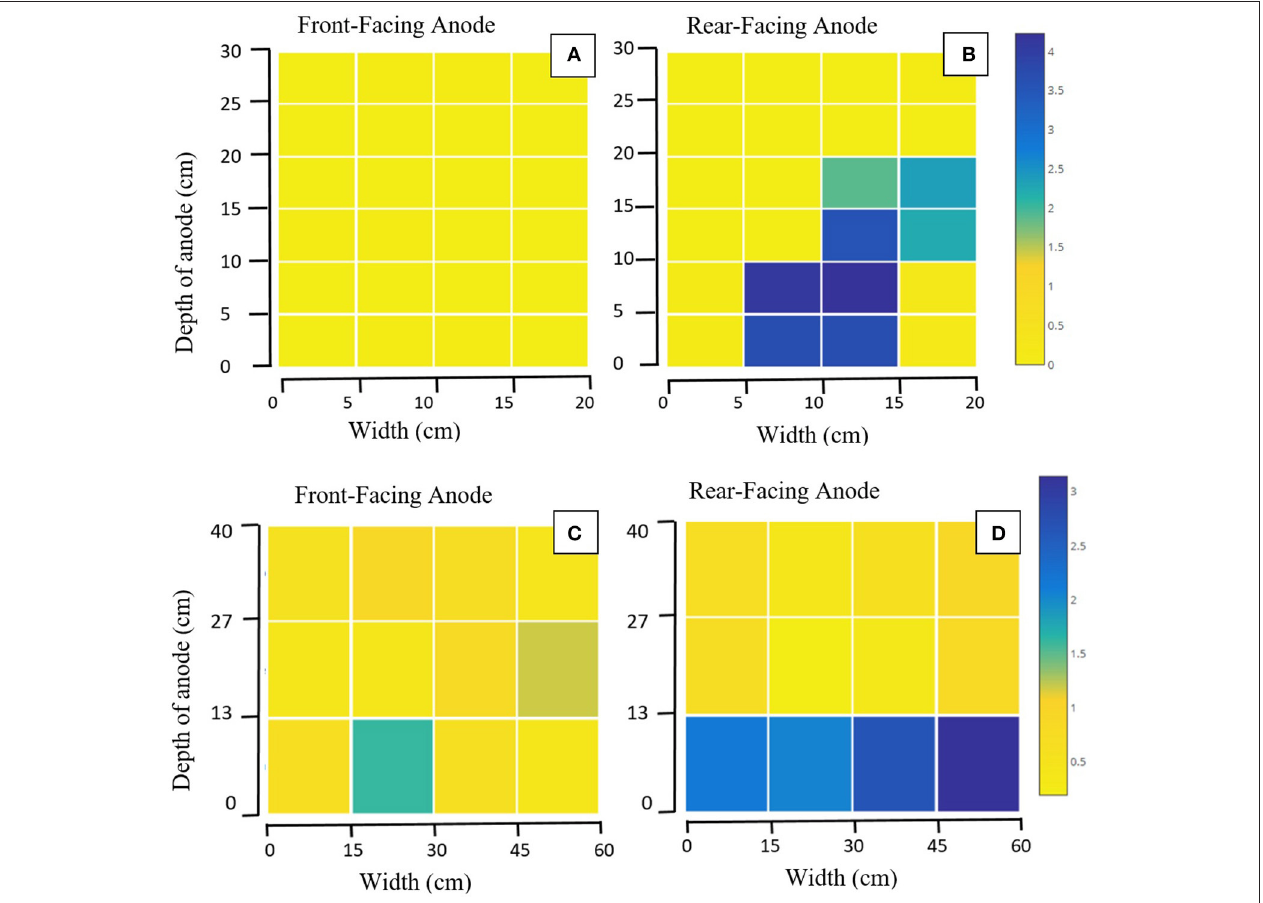
FIGURE 2 | Heat maps showing the relative abundance (%) of Geobacteraceae from transect sampling across four anodes: (A) Front-facing anode of MEC1, (B) Rear-facing anode of MEC1, (C) Front-facing anode of MEC2, (D) Rear-facing anode of MEC2. Each square represents one sample taken: with 24 taken from each of (A,B) , and 12 taken from each of (C,D) . Axes show the distance in cm from the bottom left corner of the